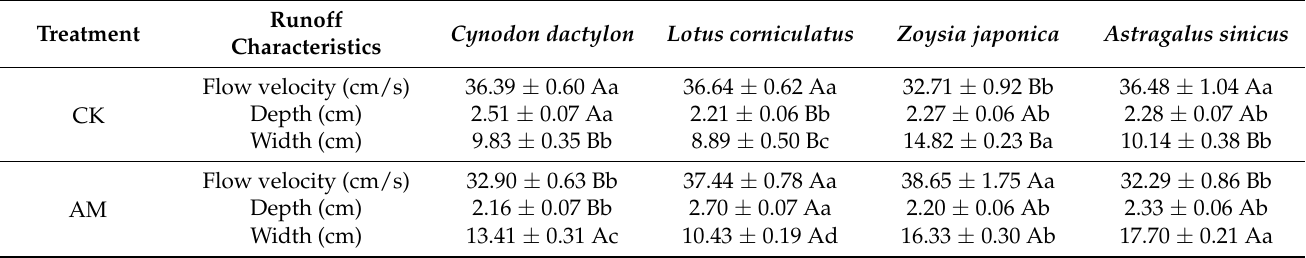
Table 2. Runoff characteristics in different soil troughs under simulated scouring in Cynodon dactylon , Lotus corniculatus , Zoysia japonica , and Astragalus sinicus . Different capital letters in the same column indicate that the same runoff characteristic is significantly different between treatments ( p < 0.05); different lowercase letters in the same row indicate that the same runoff characteristic is significantly different between grass types ( p < 0.05). Values are given as mean ± standard